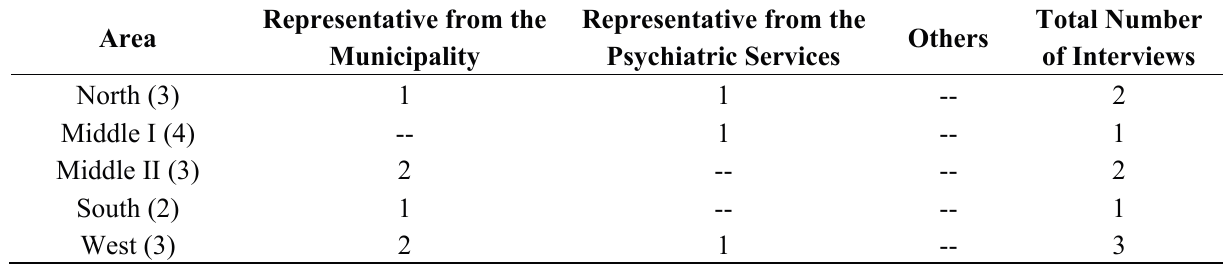
Table 4. Description of the collected data. Interviews with key persons at the regional level during the